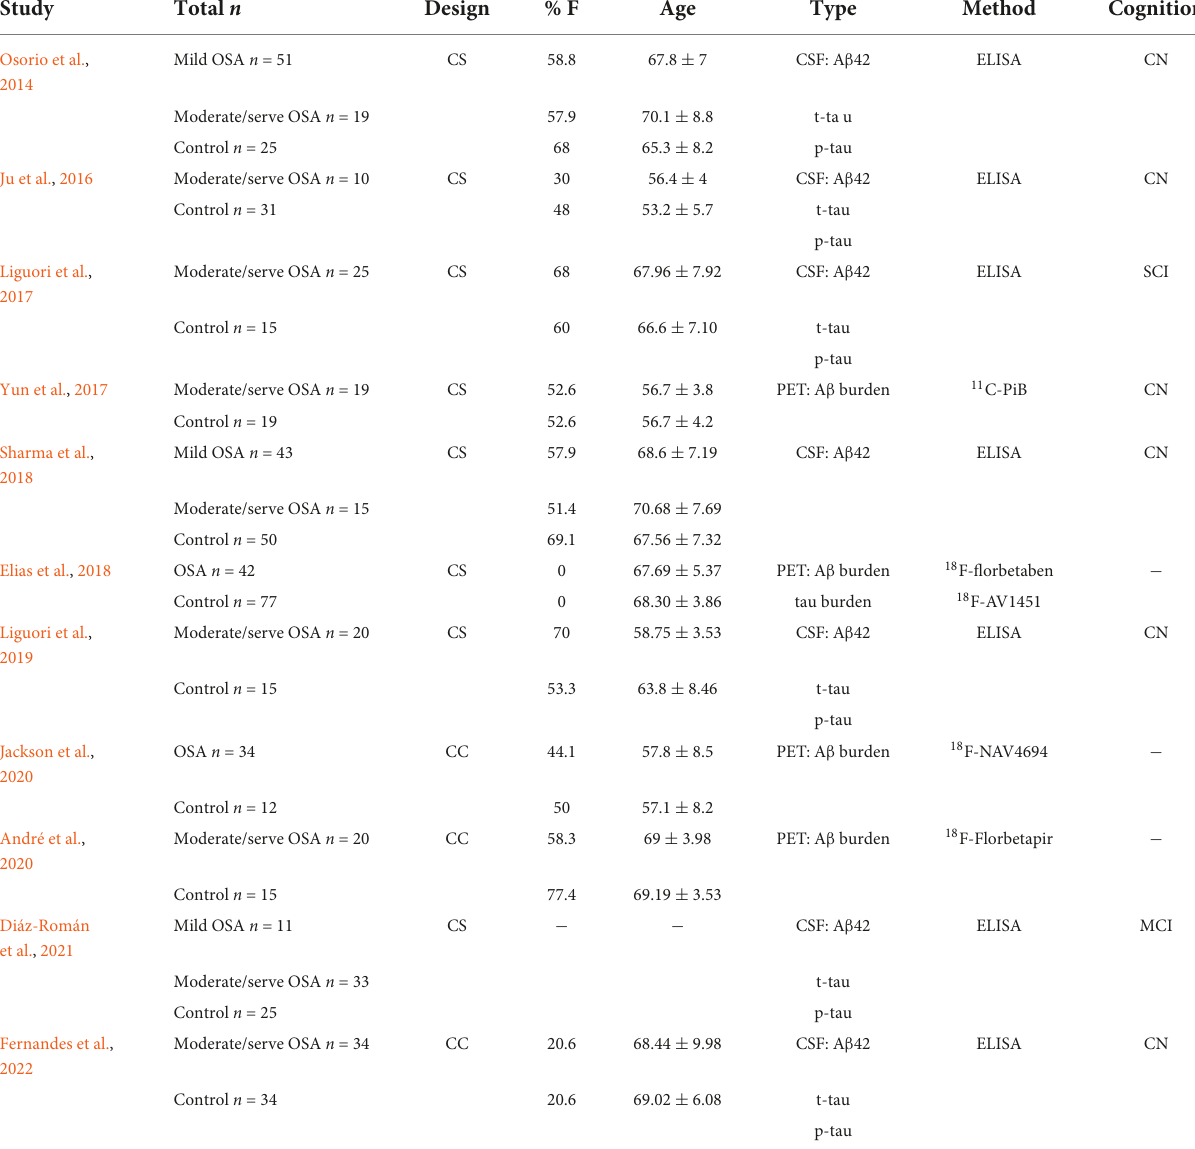
TABLE 1 Extracted and summarized details on subjects, methods, and measurements of the included studies.